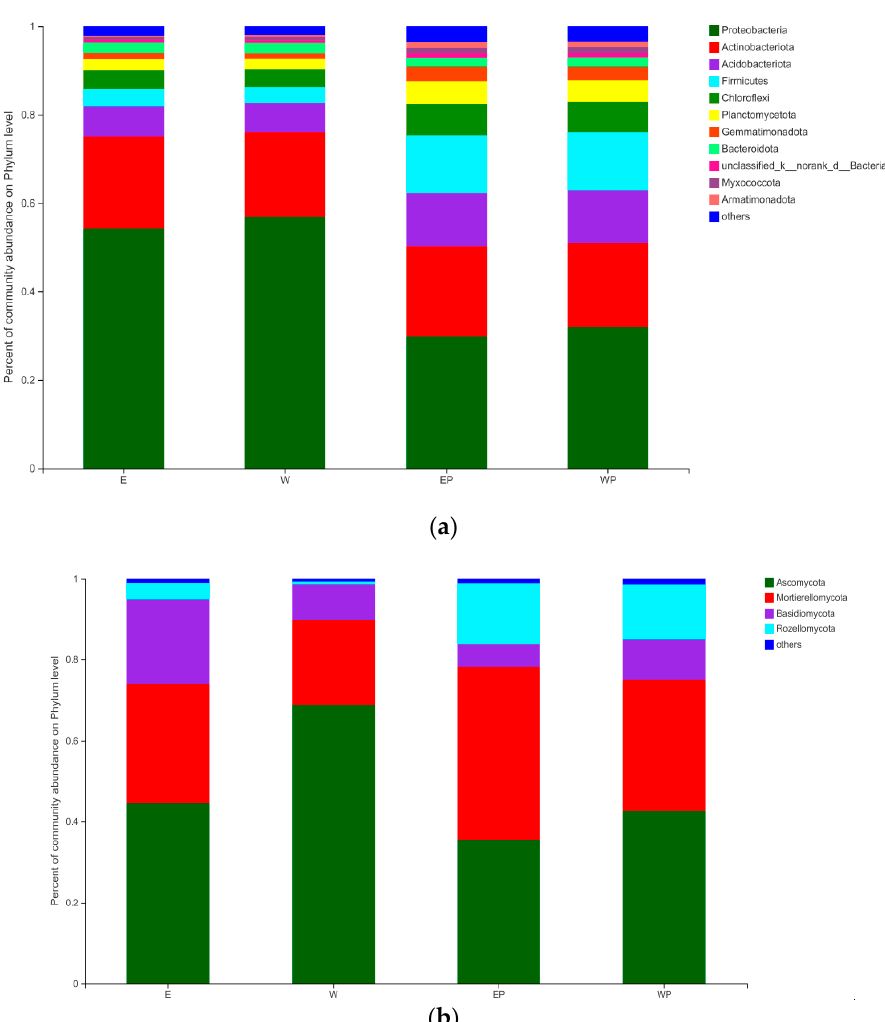
Figure 5. Relative abundances of different bacterial and fungal taxa at the phylum level in grapevine replanting soil by applying peanut root exudates or distilled water. ( a ) Bacteria; ( b ) fungi. E: grapevine replanting soil irrigated with peanut root exudates, W: grapevine replanting soil irrigated with distilled water, EP: rhizosphere soil of grapevine seedling irrigated with peanut root exudates for 28 d+24 d, WP: rhizosphere soil of grapevine seedling irrigated with distilled water for 28 d+24 d. Those with a relative abundance of less than 1% were grouped as “Others.”.